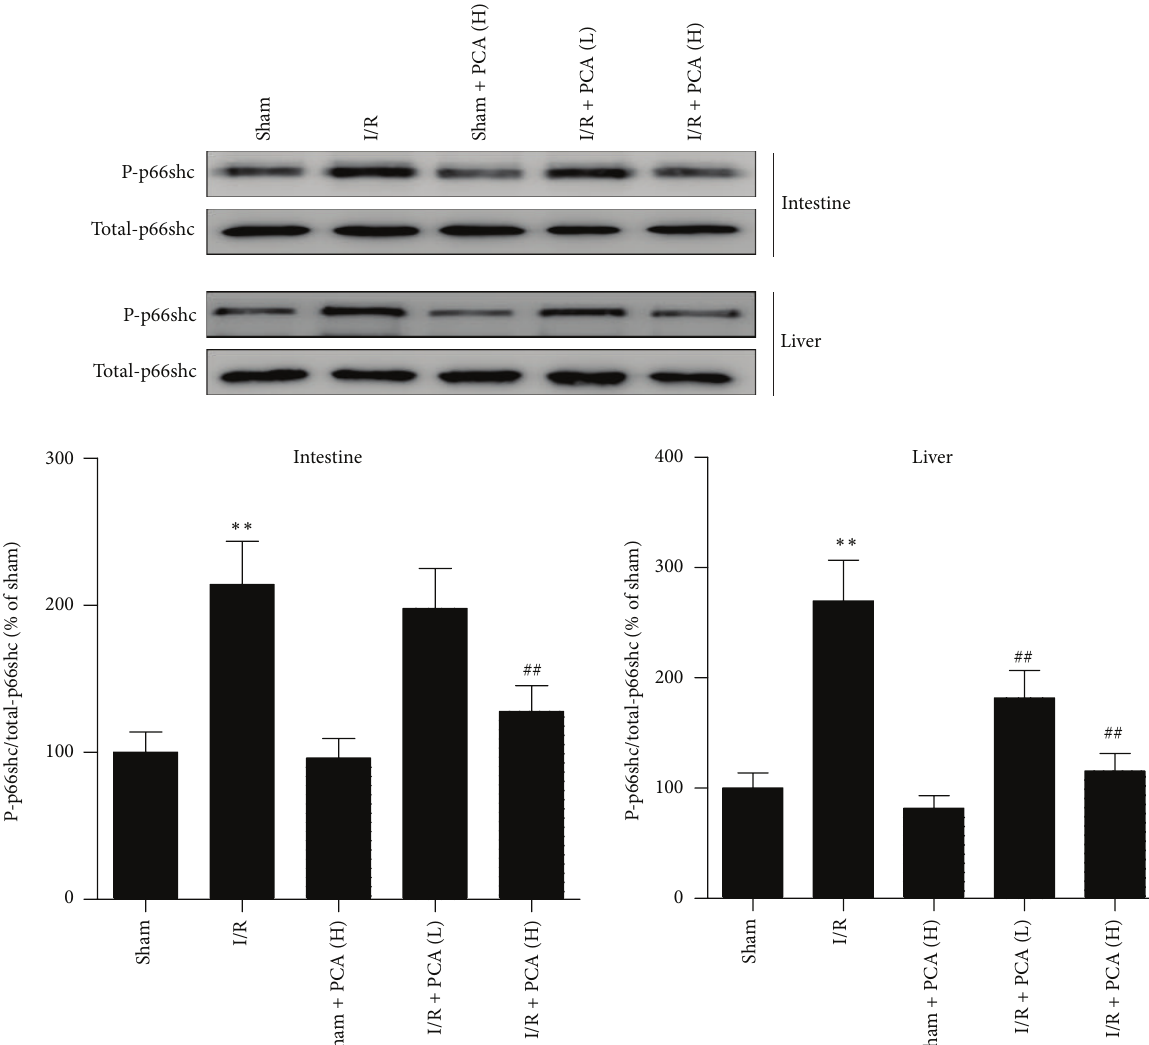
Figure 5: PCA pretreatment suppressed the phosphorylation of p66shc in the intestine and liver after intestinal I/R. Results are presented as the mean ± SD, 𝑛 = 3 . ∗∗ 𝑃 < 0.01 versus sham group; ## 𝑃 < 0.01 versus I/R